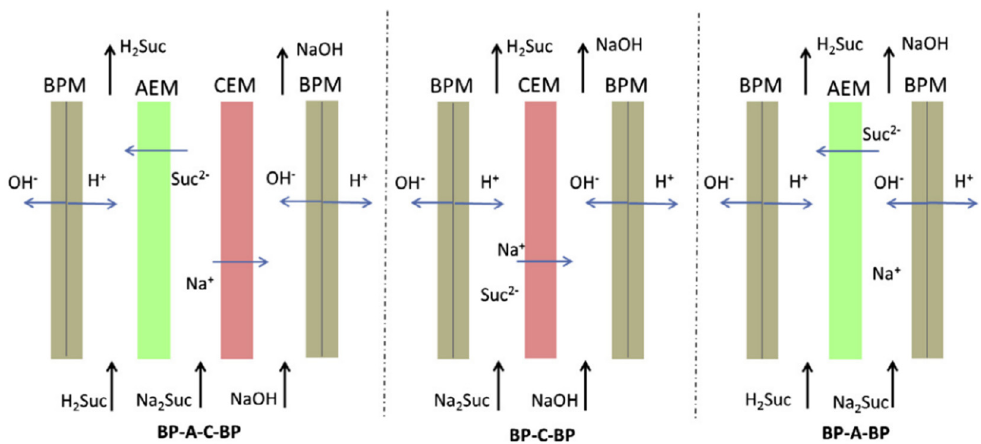
Figure 8. Schematic overview of the three configurations used to convert sodium succinate to succinic acid [73].